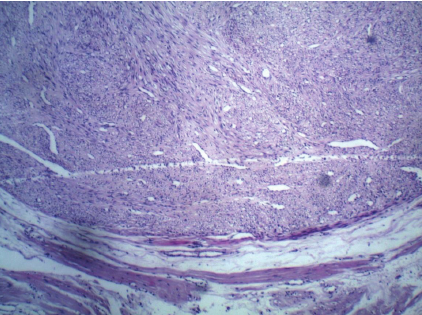
Figure 4: Postoperative appearance of the vulvar